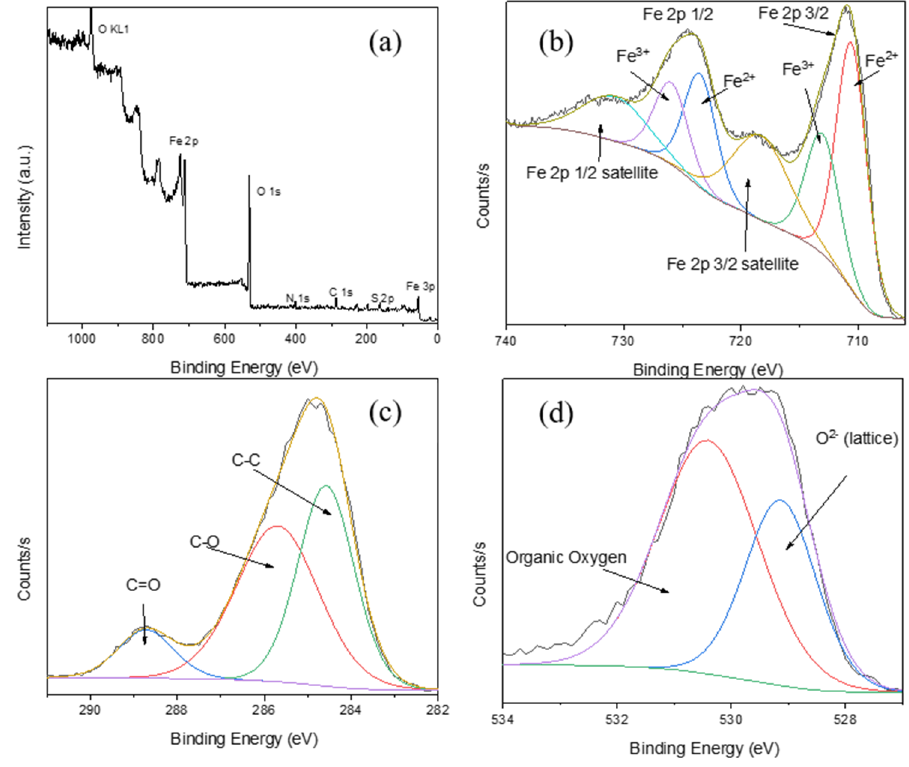
Figure 3. XPS analysis of Fe 3 O 4 functionalized with L-Cys. ( a ) Survey spectrum and high-resolution spectra of ( b ) Fe 2p, ( c ) C 1 s and ( d ) O 1 s.